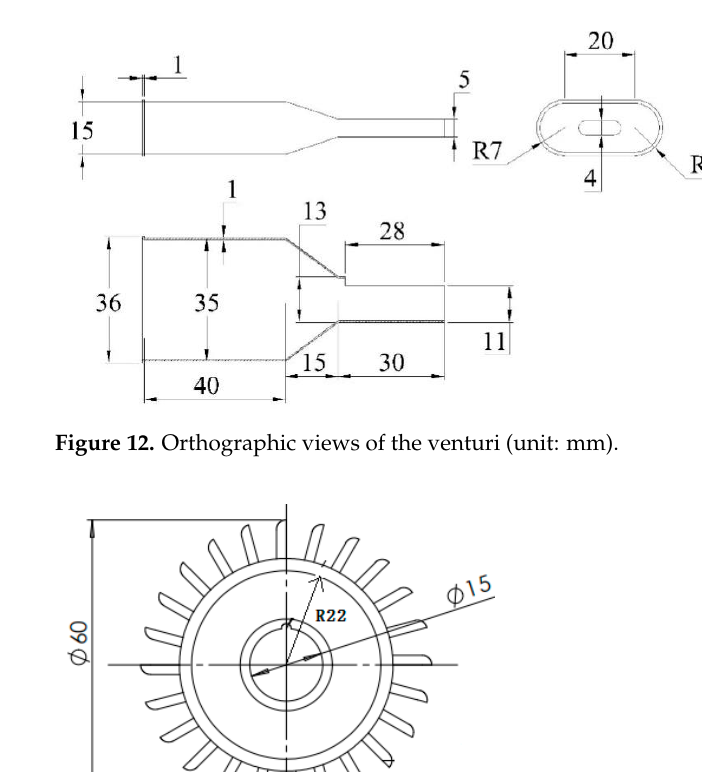
Figure 13. Dimensioned drawing of the water wheel (unit: mm) .